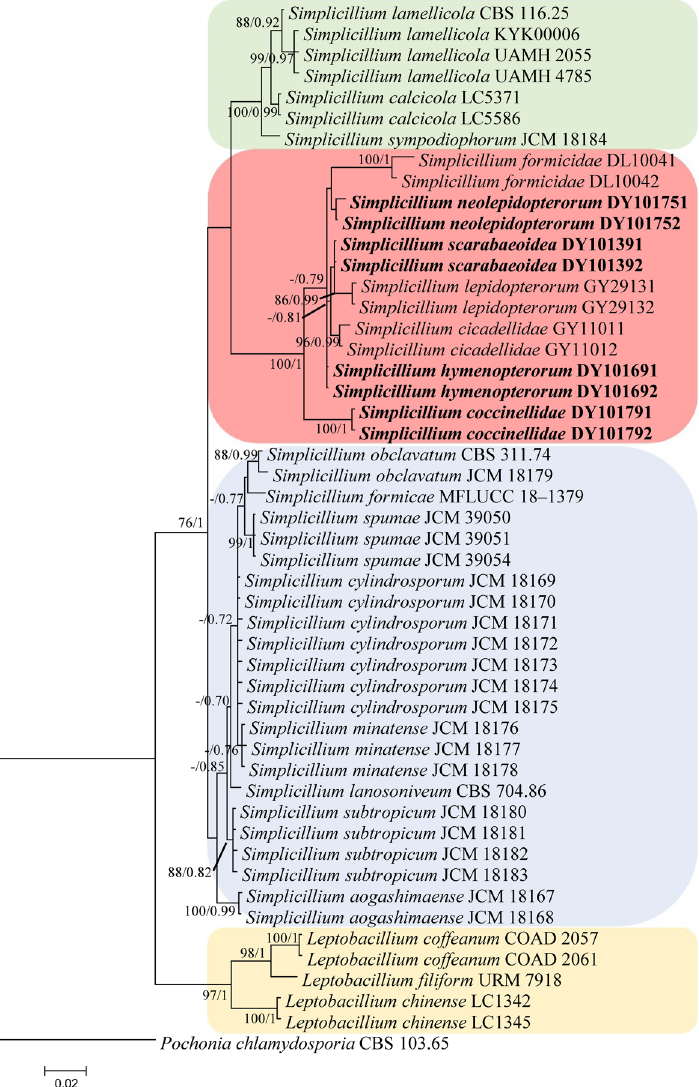
Figure 2. Phylogenetic relationships among the new taxa, other Simplicillium species and closely-related species by SSU + ITS + LSU sequences. Statistical support values (≥ 70%/0.7) are shown at the nodes for ML bootstrap support/BI posterior